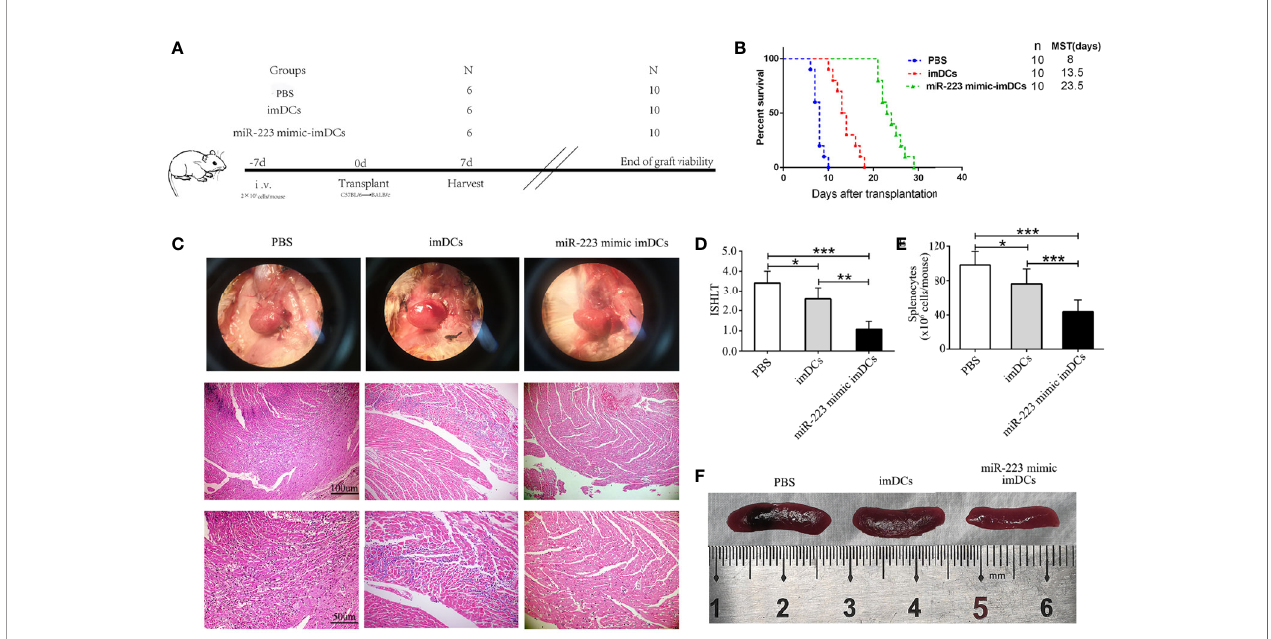
FIGURE 6 | In vivo transfer of miR-223-overexpressing imDCs prolongs heart allograft survival. C57BL/6 and BALB/c mice were chosen as donors and recipients, respectively. MiR-223 mimic-transfected imBMDCs, imBMDCs, and PBS were injected. (A) Schematic of the study design. (B) A Kaplan – Meier survival curve of heart allografts in three groups is presented by day post-transplantation and relative survival (Kaplan – Meier survival analysis). (C) Recipient mice in three groups were euthanized at 7 days post-transplantation, and then allograft hearts were harvested and stained with H&E (original magni fi cations, ×100, ×200). (D) Assessment of graft-in fi ltrating in fl ammatory cells of heart allografts in three groups at 7 days after transplantation. (E) Cell counting of spleens in three groups. (F) Morphological characteristics of spleen obtained from three groups. Data are presented as mean ± SD and represent six experiments. *P < 0.05; **P < 0.01; ***P <